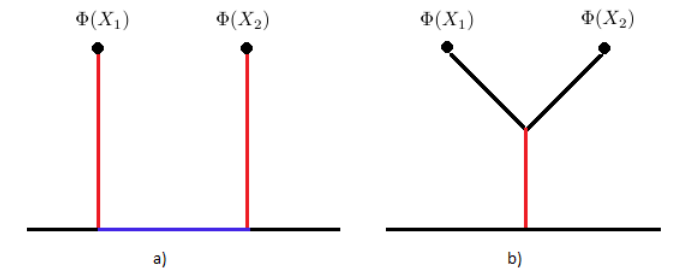
Figure 3 . a) U-Channel: the bulk operators are decomposed in terms of defect operators. We